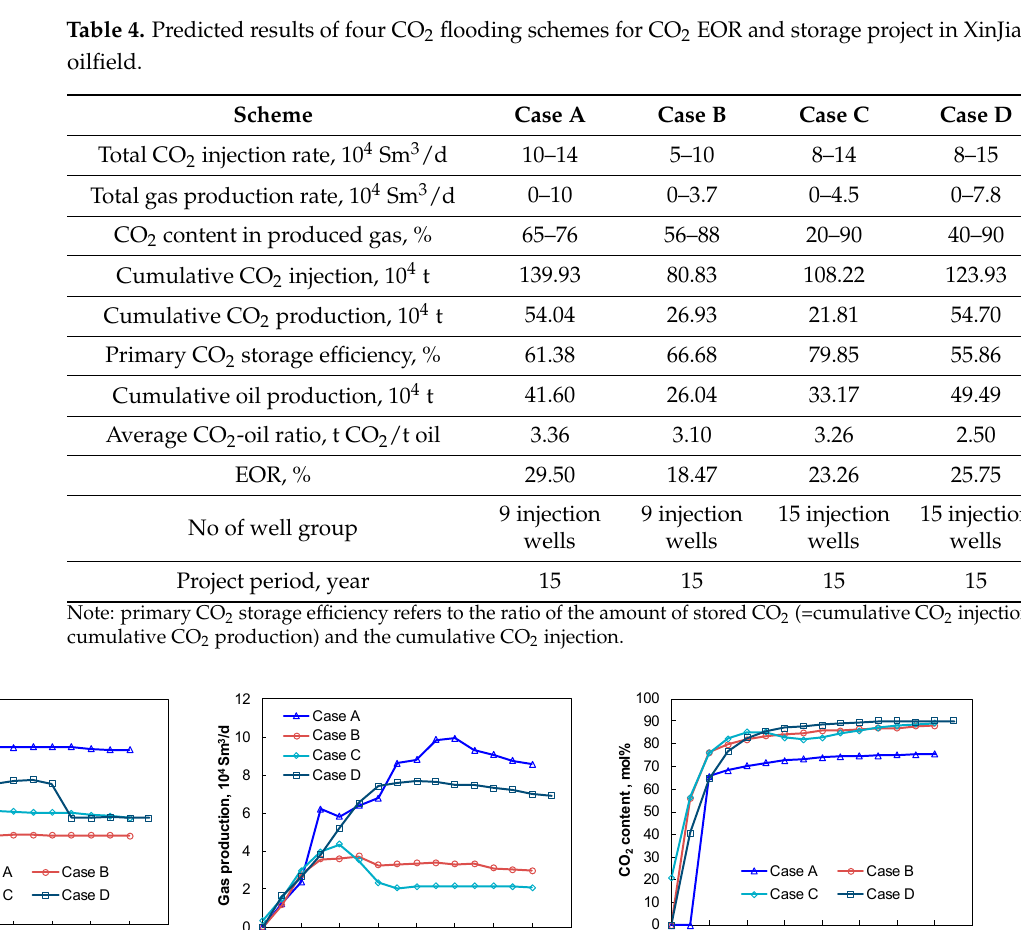
Table 4. Predicted results of four CO 2 flooding schemes for CO 2 EOR and storage project in XinJiang oilfield.